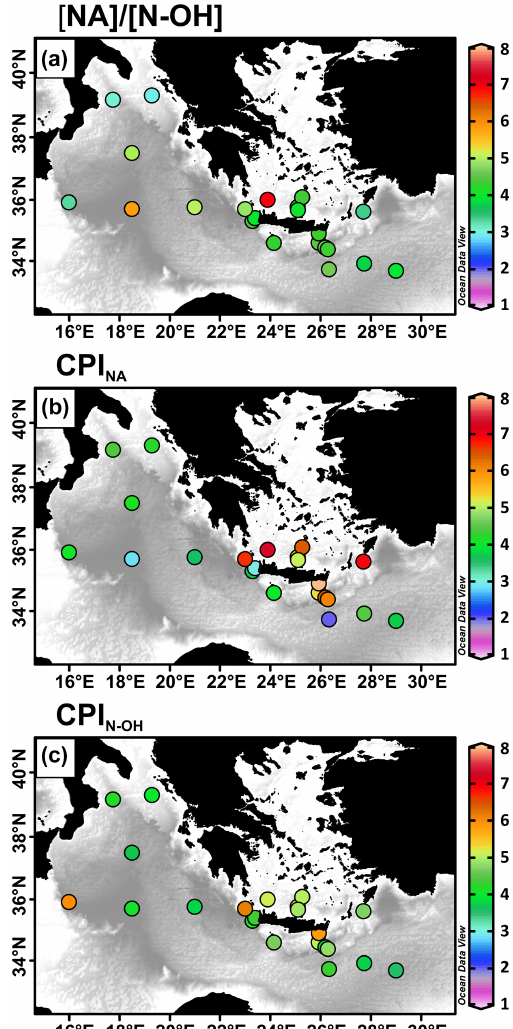
Figure 8. Spatial distribution of lipid biomarker indices (a) [NA] / [N–OH], (b) CPI NA and (c) CPI N-OH . Abbrevia- tions of lipid biomarker indices are defined in the